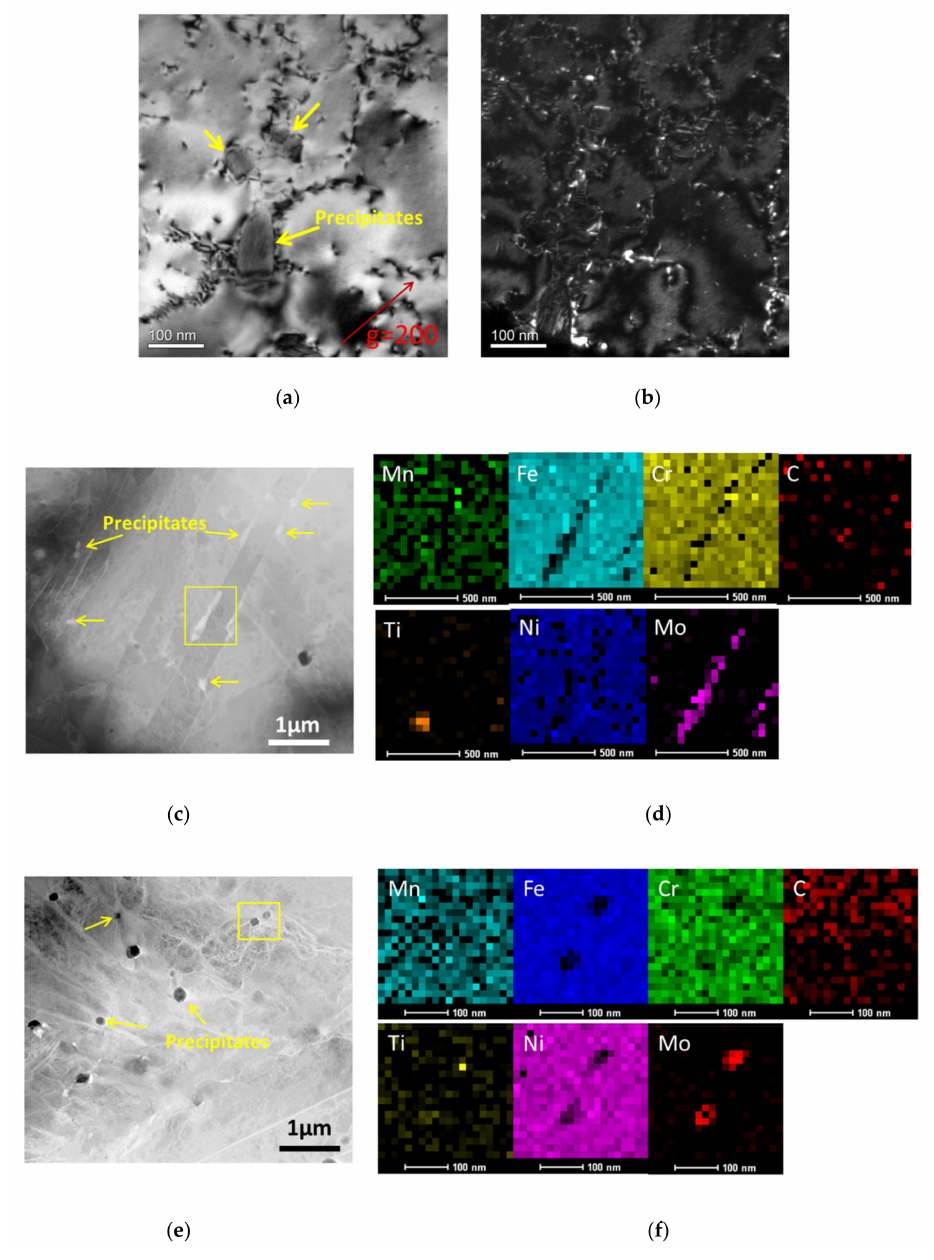
Figure 4. Precipitate observations: ( a ) transmission electron microscopy (TEM) bright field image and ( b ) weak-beam dark-field (WBDF) image after the creep test of 190 MPa; ( c ) high-angle annular dark-field (HAADF) image and ( d ) EDS images of the precipitate marked by square in the HAADF image after 190 MPa test; ( e ) HAADF image; and, ( f ) EDS images of the precipitate marked by square in the HAADF image after 300 MPa